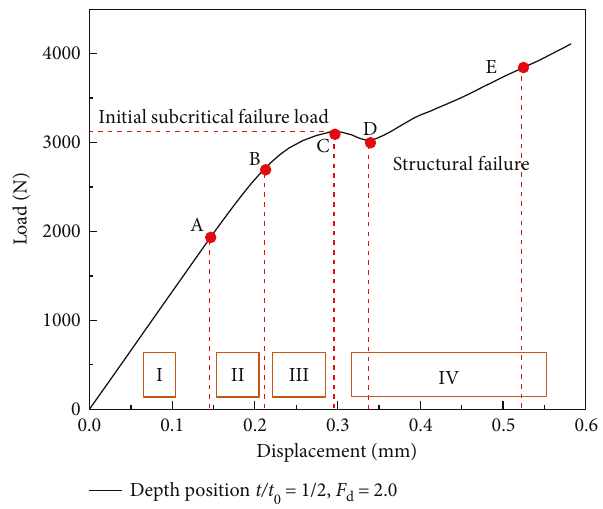
Figure 7: Typical load-displacement curve of a composite laminate with delamination